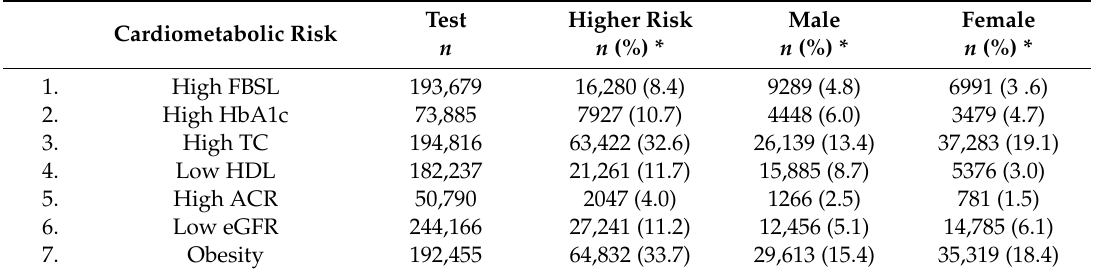
Table 2. Frequency and proportion of CMRFs risk classification with gender.